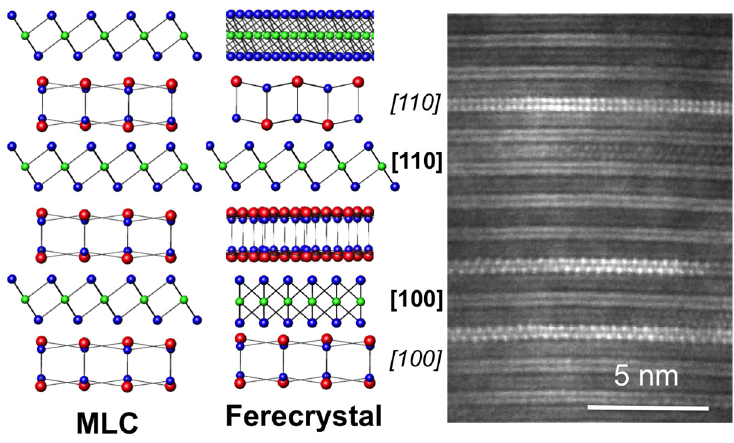
Figure 6. Comparison of 3-D crystals observed in misfit layer compounds and the turbostratic disorder observed in the metastable ferecrystals ( left ). HAADF-STEM image of ferecrystalline (SnSe) 1.2 TiSe 2 showing turbostratically disordered layers ( right ). Zone-axes are visible that help identify the constituents.